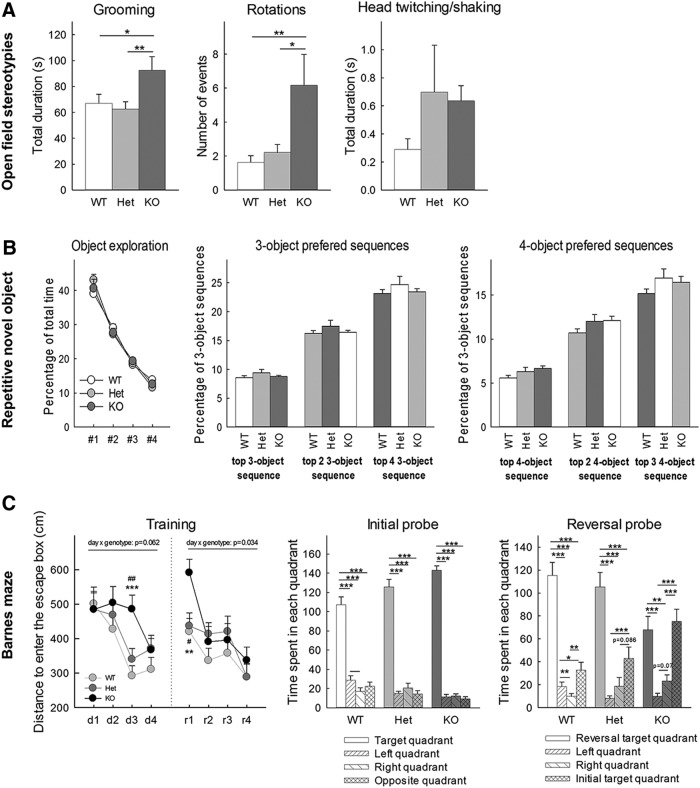
Repetitive behavior, stereotypies, and cognitive flexibility in Shank3Δ4-22-deficient mice. A, Repetitive behaviors in the open field test. Shank3Δ4-22 homozygous mice engaged in significantly more self-grooming and rotations relative to the other genotypes. A trend toward an increase amount of head stereotypies was also observed. B, Object preference and pattern of exploration in the repetitive novel object contact task. For each mouse, the time spent interacting with each object was measured and the objects were then ranked from the most (1) to less (4) preferred (left panel). No genotype differences were observed for the proportions of visits to each object. The pattern of object exploration was analyzed by recording specific sequential pattern of visits to three or four specific toys to identify the total number of three-object or four-object sequence investigations, the number of unique sequences, and the percentage of choices of the top, top two, or top three preferred sequences. All groups had identical percentage of their preferred three-object or four-object sequences choices over the total number of sequence choices. C, Cognitive flexibility measured by reversal learning in the Barnes maze. During initial learning (d1 to d4, each point represents the mean of traveled distance for four independent trials), improvement shown by reduction of the travel distance was faster in Shank3Δ4-22 wild-type and heterozygous mice than in homozygous animals; however, by day 4, the three groups were not different anymore and all of them had a strong preference for the escape hole quadrant during the initial probe test. During the reversal training (r1 to r4, each point represents the mean of travel distance for four independent trials), Shank3Δ4-22 homozygous mice initially traveled for longer distances but were still able to learn the new position and performed as well as their littermates on reversal days 2, 3, and 4. However, the reversal probe test at the end of the reversal training showed that while wild-type and heterozygous animals had a significant preference for the new target quadrant, the homozygous mice had a similar preference for the quadrants containing the initial and the reversal escape holes. WT, wild-type mice; Het, heterozygous mice; KO, homozygous knock-out mice. *: WT versus KO; #: Het versus KO. *p < 0.05, **p < 0.1, ***p < 0.001.